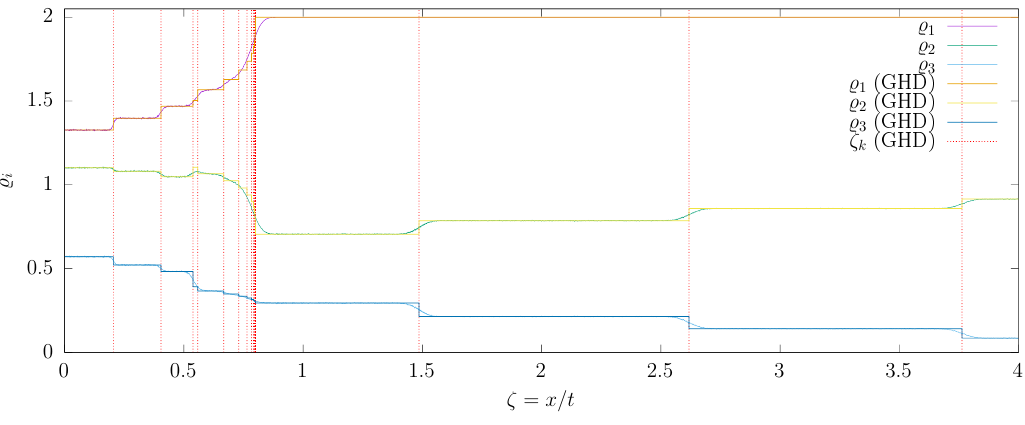
(2) dynamics. We again have an infinite series l =100 0 . 80019 (cid:39)